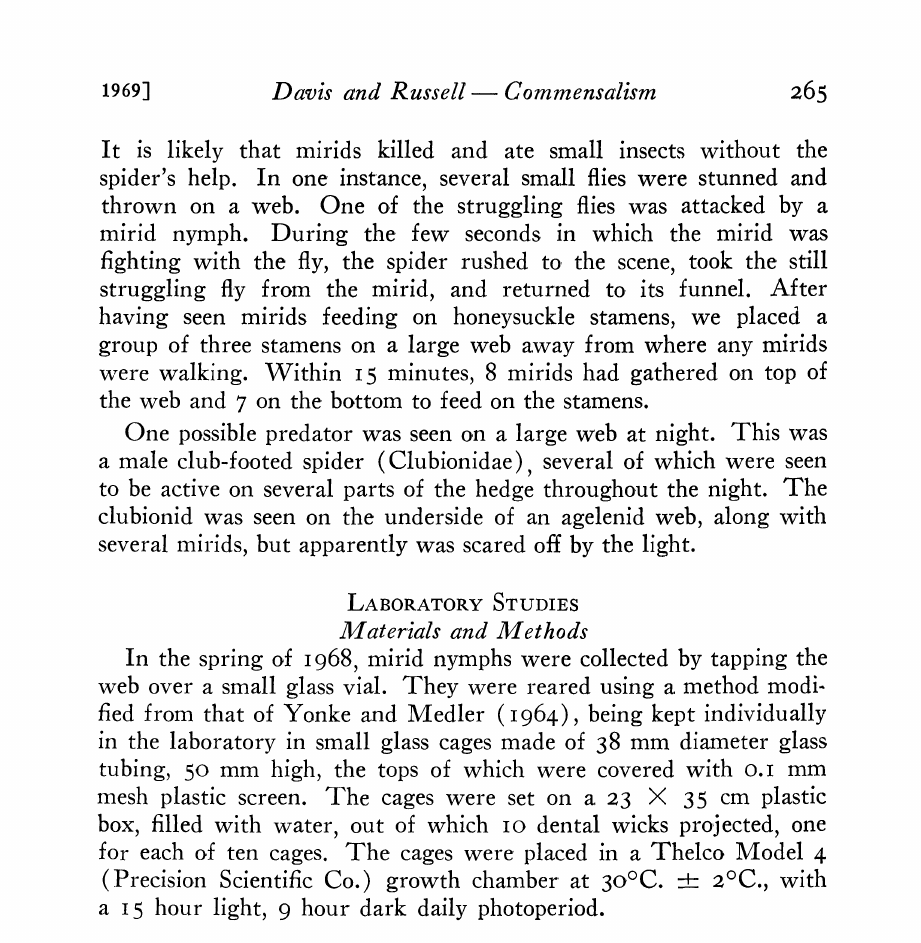
Table 1. Duration (days) of the nymphal stadia of 20 Ranzovius moerens* reared to maturity. (AfterWilkinson and Daugherty, 1967) Stadium